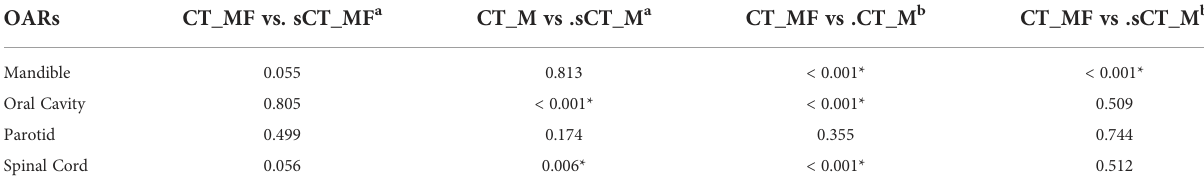
TABLE 2 P value comparison of RED distributions for